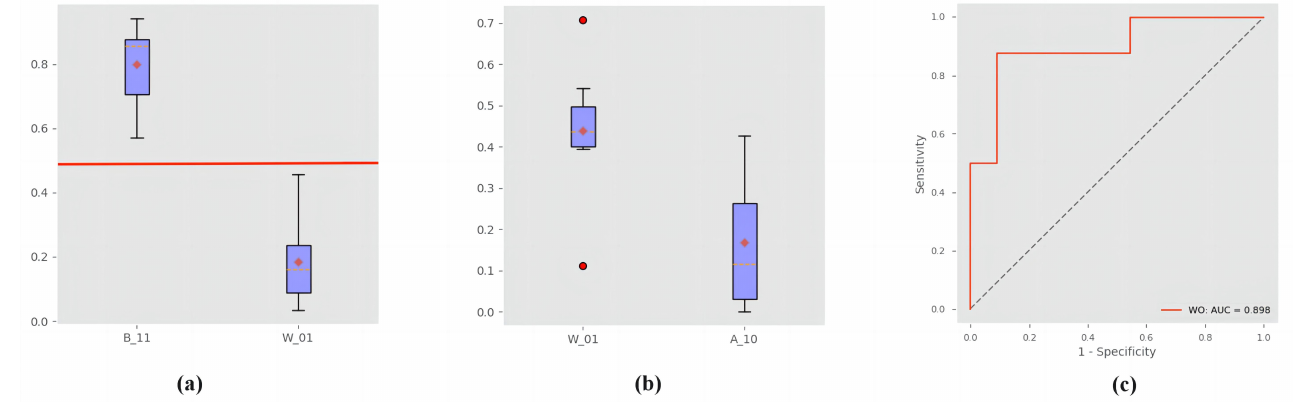
Figure 9. Classification results: ( a , b ) show the boxplot of APHE and WO volume ratio, respectively; ( c ) shows the ROC curve of WO volume ratio.